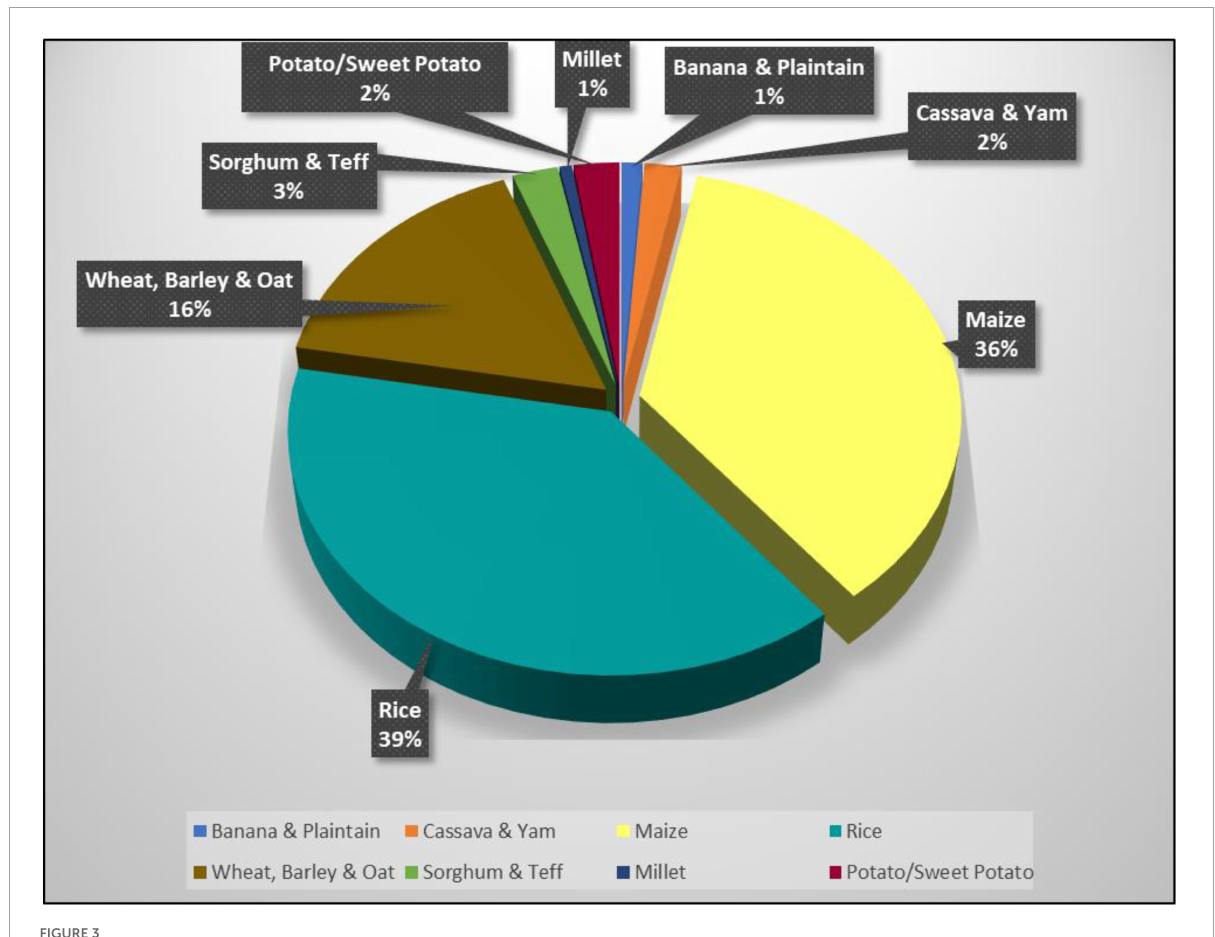
FIGURE3 Types of crops identified in the reviewed articles.